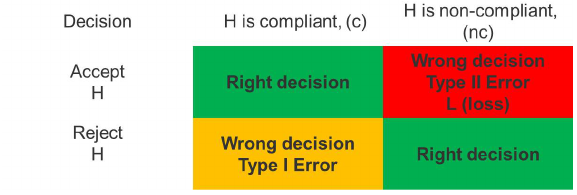
Figure 4: Possible outcomes of verification